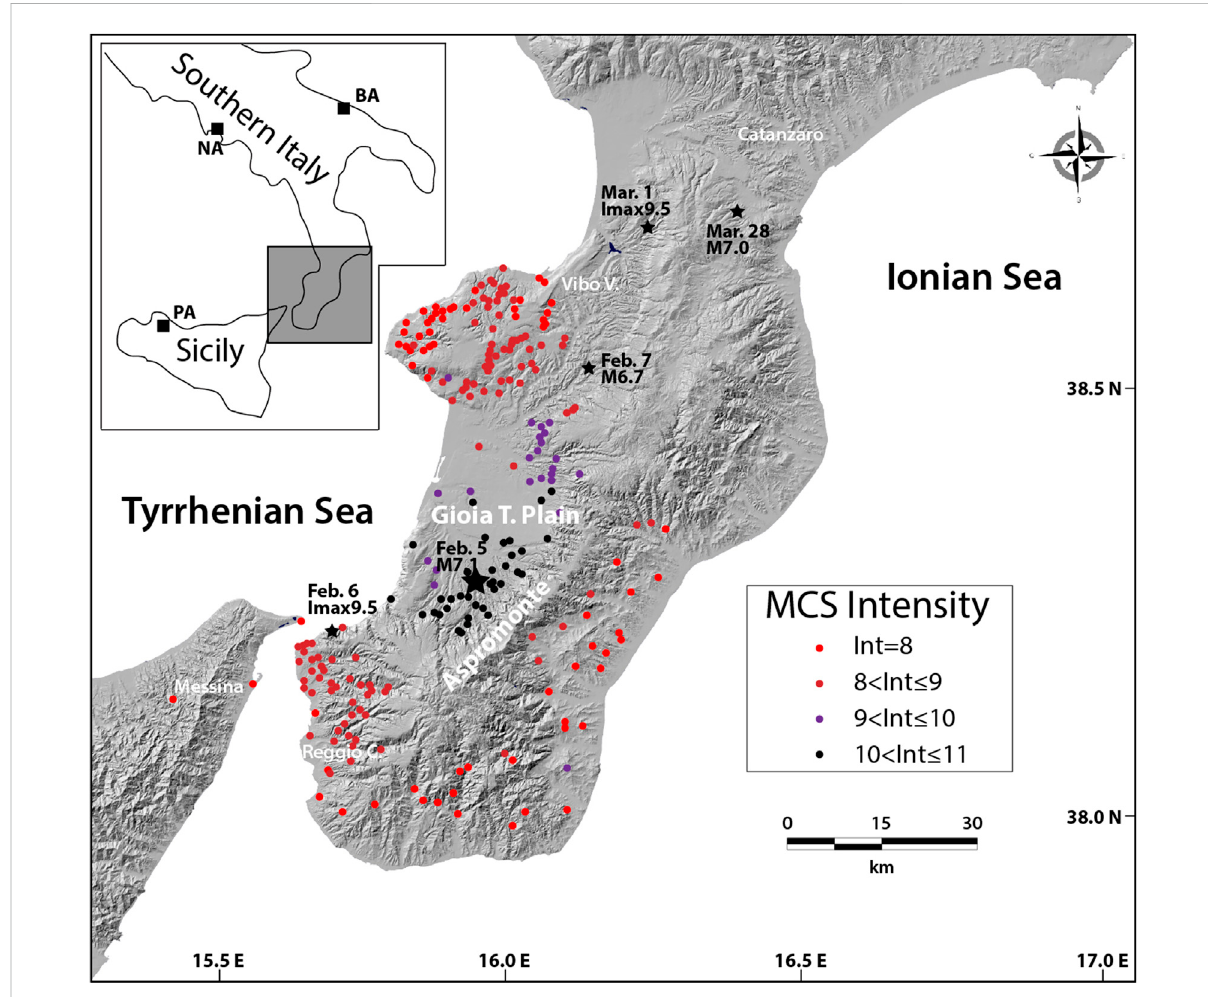
FIGURE 1 Map of the highest MCS intensities (Int > 8; Rovida et al., 2021) associated with the 5 February 1783 earthquake. The epicenter of the event is markedbyalargeblackstar.Themapalsoshows(withsmallblackstars)thelocationofthefourmostpowerfulearthquakesthatoccurredduringthe 1783 seismic sequence. Key for the main towns in the inset:BA, Bari; NA, Naples; PA